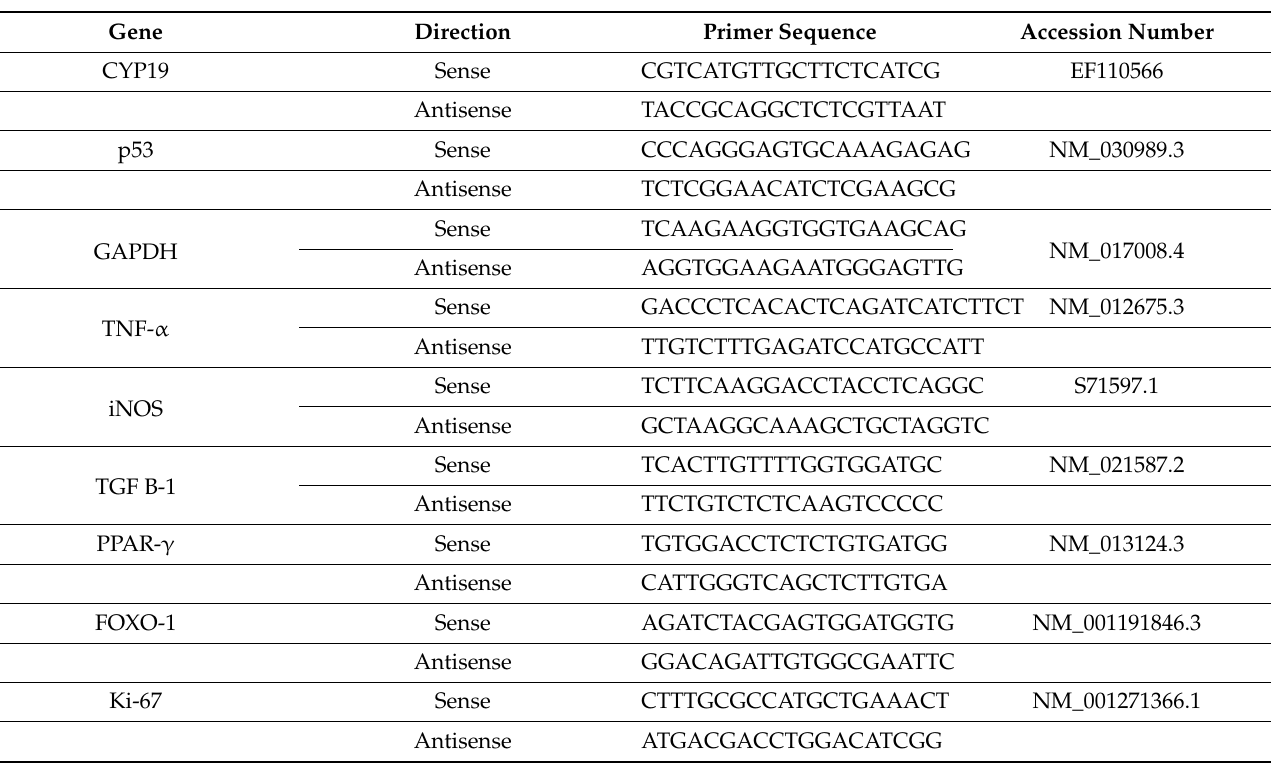
Table 1. Primers for gene expression by